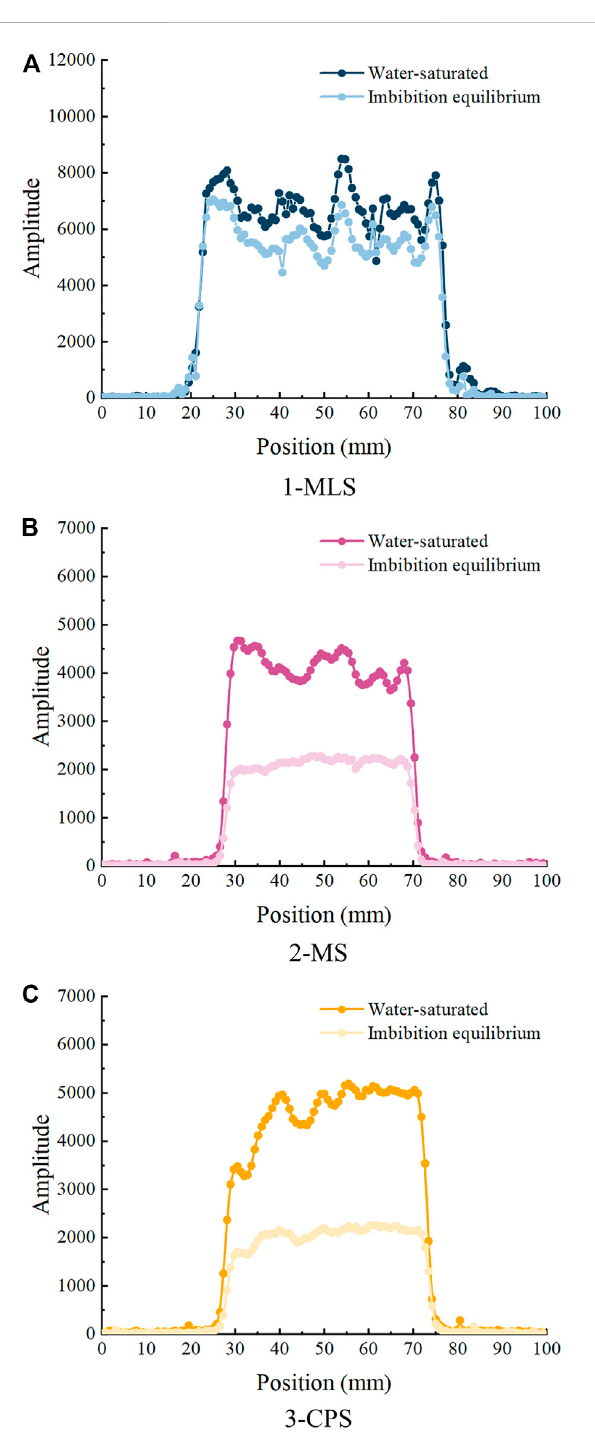
FIGURE 10 Theresults of1Dfrequencyscanningfordifferentcore samples: (A) MLS sample; (B) MS sample; (C) CPS